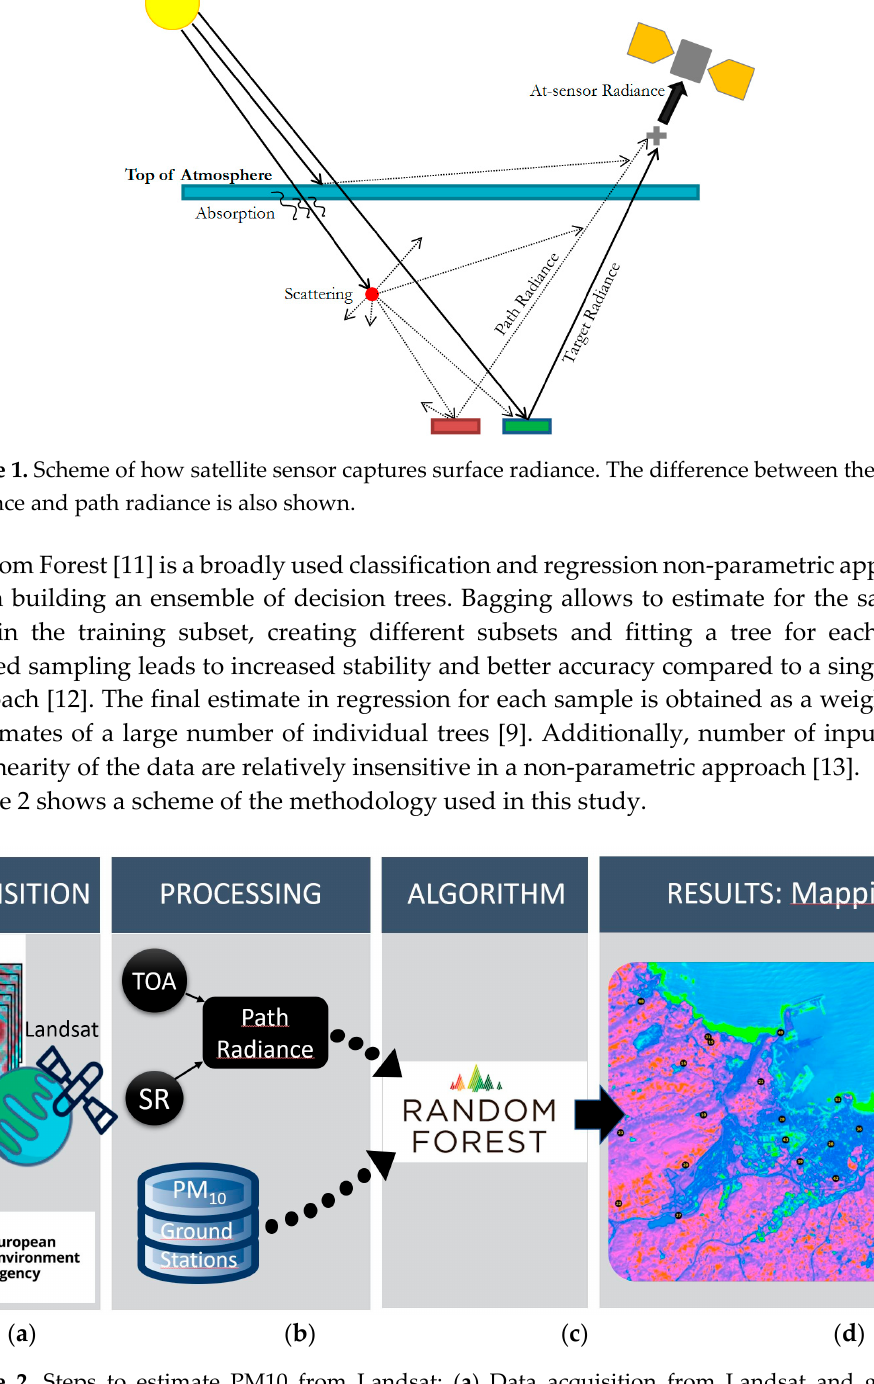
Figure 2. Steps to estimate PM10 from Landsat: ( a ) Data acquisition from Landsat and ground measurements; ( b ) Processing to obtain path radiance; ( c ) Using Random Forest (RF) algorithm; ( d ) Obtain spatially continuous PM10